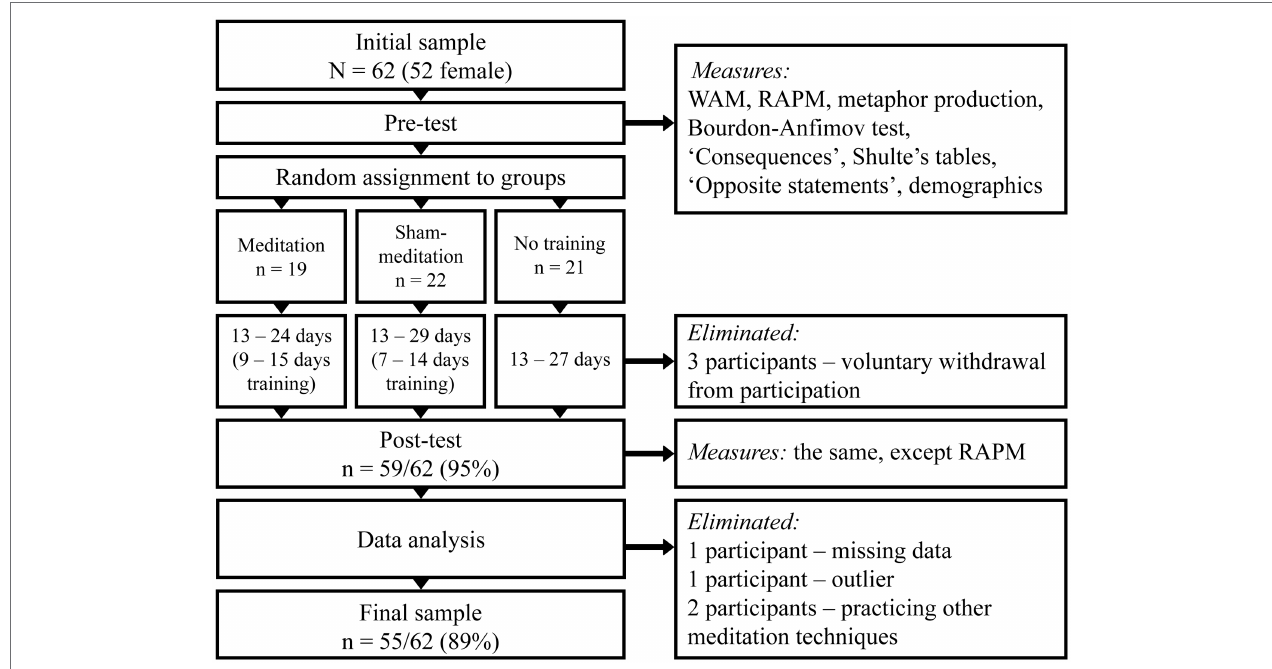
FIGURE 2 | Schematic representation of the procedure and the flow of